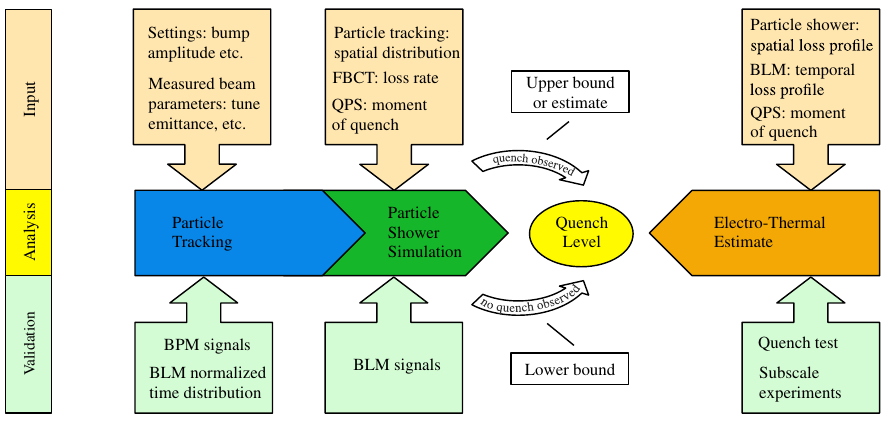
FIG. 3. Overview of the analysis methodology for quench